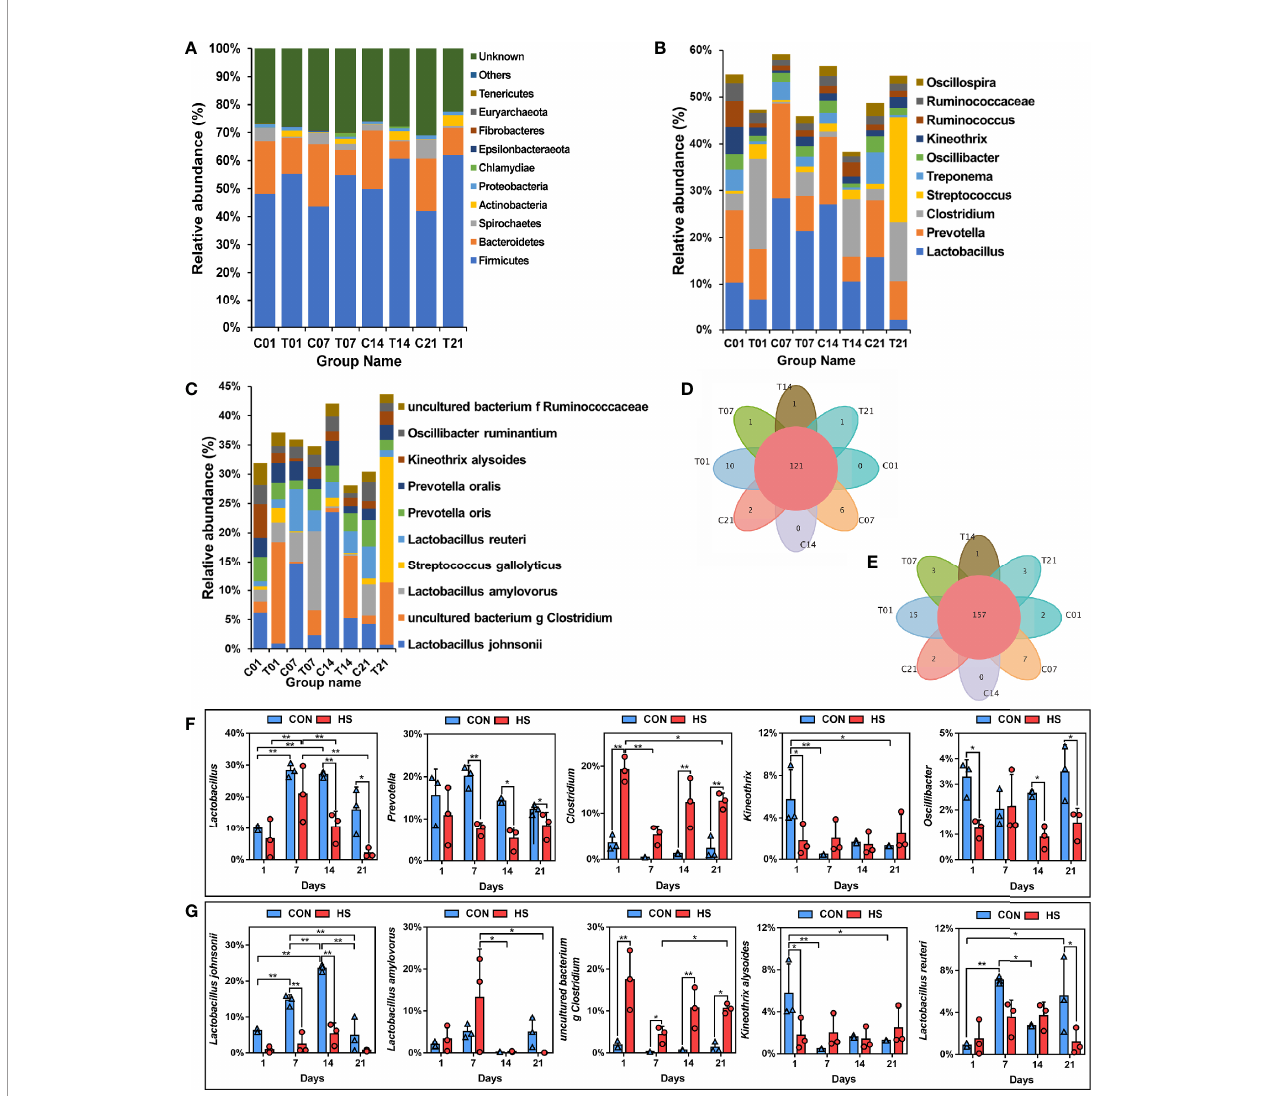
FIGURE 7 | Effect of HS on the microbial structure of pig colon. CON and C indicate no heat stress group, HS and T indicate heat stress treatment, 1, 7, 14, 21 indicate day 1, 7, 14, and 21 groups respectively, n = 3; “ * ” indicates p < 0.05, “ ** ” indicates p < 0.01. (A) TOP10 by phylum level; (B) TOP15 by genus level; (C) TOP15 by species level; (D) Venn plot of genus level; (E) Venn plot of species level; (F) differences of phylum level by TOP5; (G) differences of genus level by